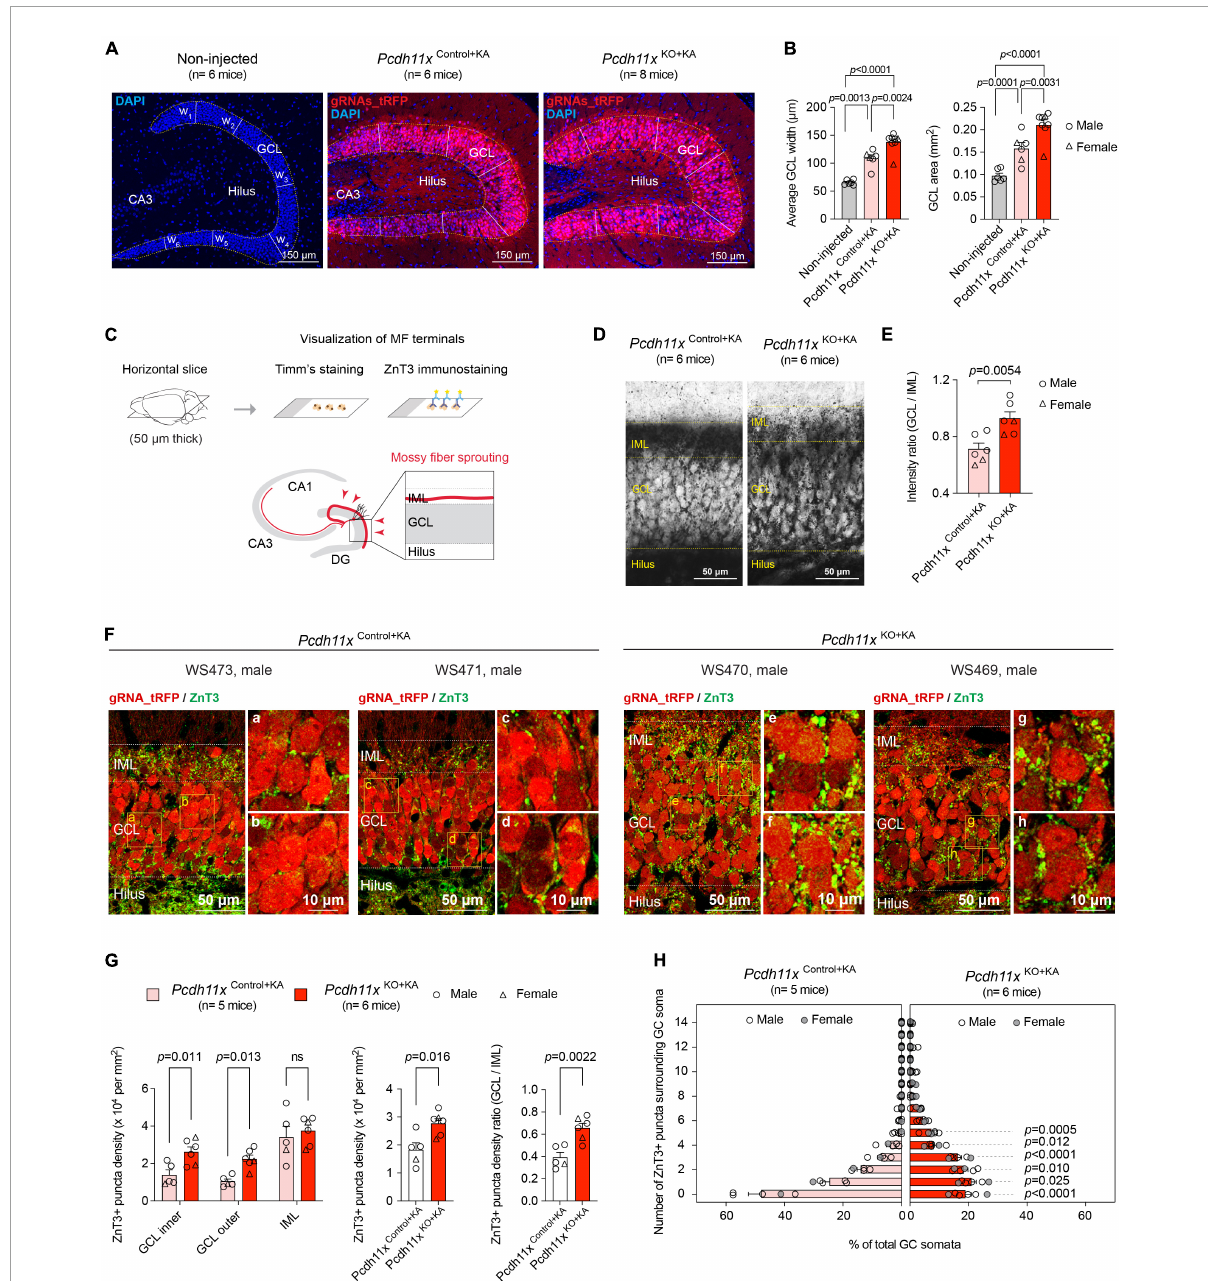
FIGURE4 Impact of Pcdh11x KO on MF sprouting. (A) Confocal images show DAPI immunostaining and virally-delivered tRFP signal in the dentate gyrus of non-injected control, Pcdh11x Control + KA , and Pcdh11x KO + KA mice. In each sample, the width of GCL was determined as the average of six width measurement (w 1 to w 6 ) based on DAPI staining. (B) Left plot shows quantification of average GCL width in non-injected, Pcdh11x Control + KA , and Pcdh11x KO + KA samples. The transfected area was localized based on the tRFP signal. Right plot shows quantification of GCL area (quantified as the circumference of DAPI staining) in non-injected, Pcdh11x Control + KA , and Pcdh11x KO + KA samples. Each data point represents one animal (one-way ANOVA tests, F (2,17) = 29, p < 0.0001; p -values of the post hoc analyses are indicated in the figure). (C) Experimental design for visualizing MF boutons by Timm’s staining and ZnT3 immunostaining. (D) Timm’s staining shows stratification of MF boutons in Pcdh11x Control + KA and Pcdh11x KO + KA mice. (E) Quantification of Timm’s signal intensity between GCL and IML in Pcdh11x Control + KA and Pcdh11x KO + KA mice (Welch’s t -test). (F) ZnT3 staining shows stratification of MF boutons in Pcdh11x Control + KA and Pcdh11x KO + KA mice. Areas highlighted with boxes are shown in higher magnification in panels (a–h) . (G) Quantification of ZnT3 + puncta density in the inner and outer half of GCL and in IML [left plot; two-way ANOVA, F Layer (2,18) = 31, p < 0.0001; F KO (1,9) = 7.8, p = 0.021; F LayerxKO (2,18) = 1.9, p = 0.18; post hoc analyses: Pcdh11x Control + KA vs Pcdh11x KO + KA , GCL inner: p = 0.01; GCL outer: p = 0.013; IML: ns, p = 0.46], in GCL and IML together (middle plot; Welch’s t -test, p = 0.016), and the GCL/IML ratio of ZnT3 + puncta density (right plot; Welch’s t -test, p = 0.0022). (H) Distribution of GC somata (in %) that are surrounded by 0, 1, 2, ... , 14 ZnT3 + boutons in Pcdh11x Control + KA and Pcdh11x KO + KA mice (two-way ANOVA, F # ofpuncta (14,126) = 141, p < 0.0001; F KO (1,9) = 2.8, p = 0.13; F # ofpunctaxKO (14,126) = 26, p < 0.0001; p-values of the post hoc analysis are indicated in the figure; p -values are > 0.05 for 6 or more